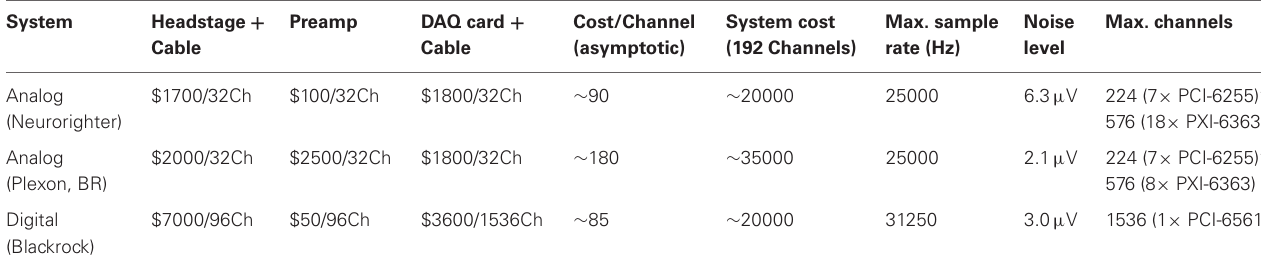
Table 1 | Overview of system